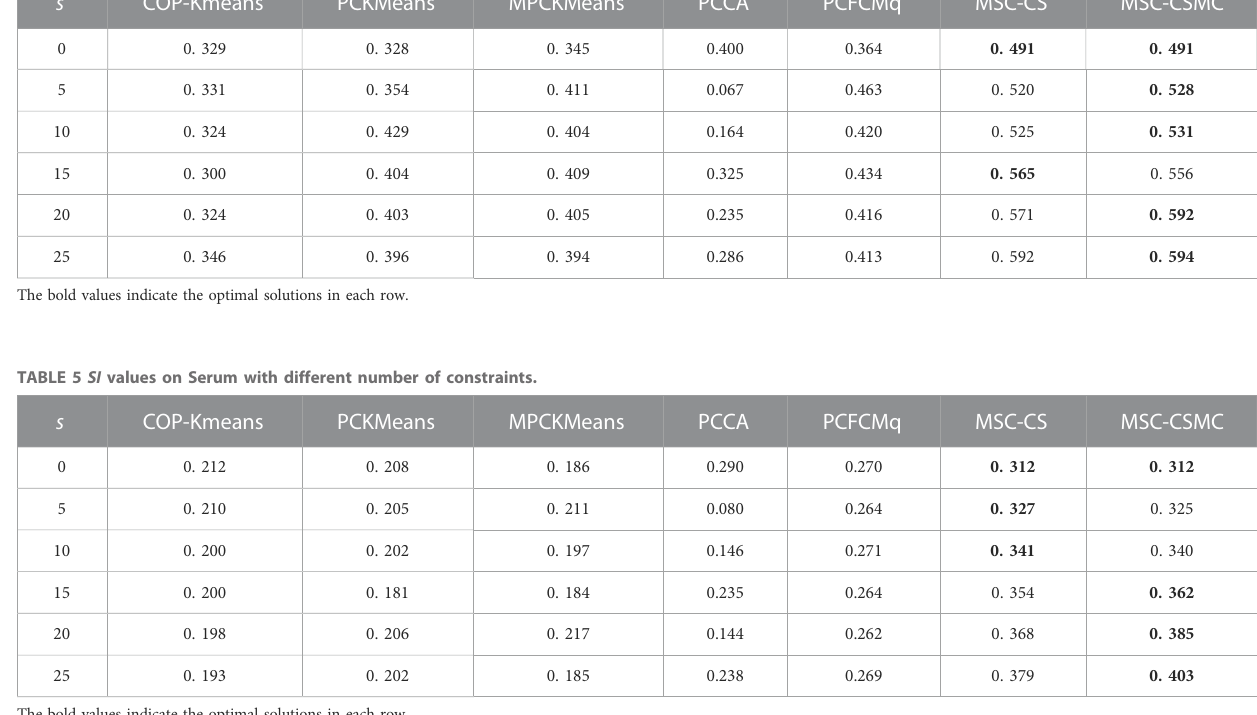
TABLE 4 SI values on Yeast Sporulation with different number of constraints.